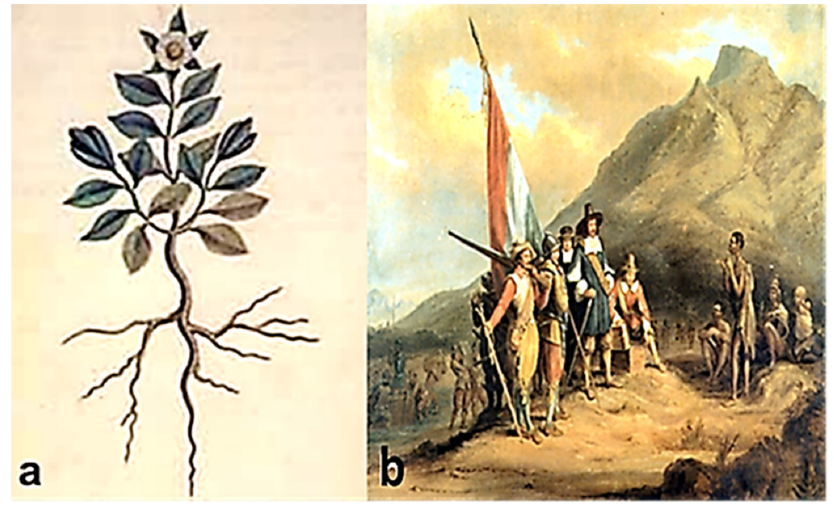
Figure 1. Sceletium painting done by Simon van der Stel in 1685 ( a ), Jan van Riebeek with his Dutch colleagues at the Cape of Good Hope ( b )